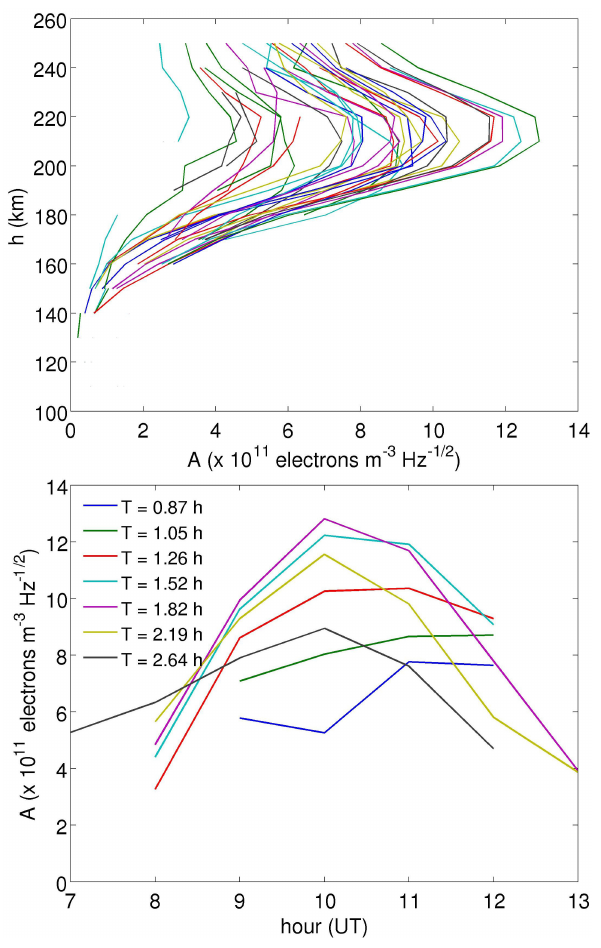
Figure 9. The amplitude spectral density A of the TID observed from 08:00 to 12:00, for T between 0.8 and 3.0h, on 20 Jan- uary 2010. Upper: as a function of altitude; lower: at h = 220km as a function of time.